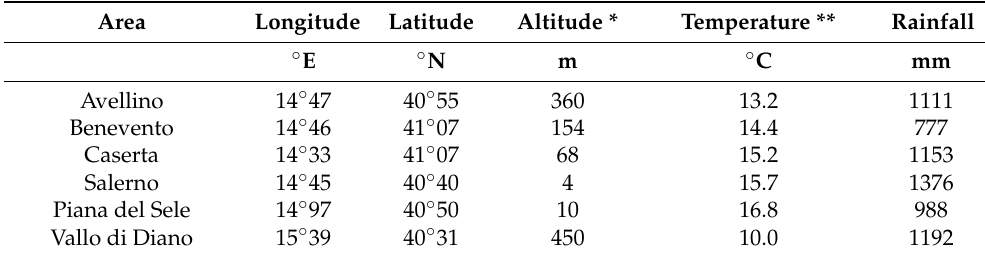
Table 1. Characteristics of the sampling areas.